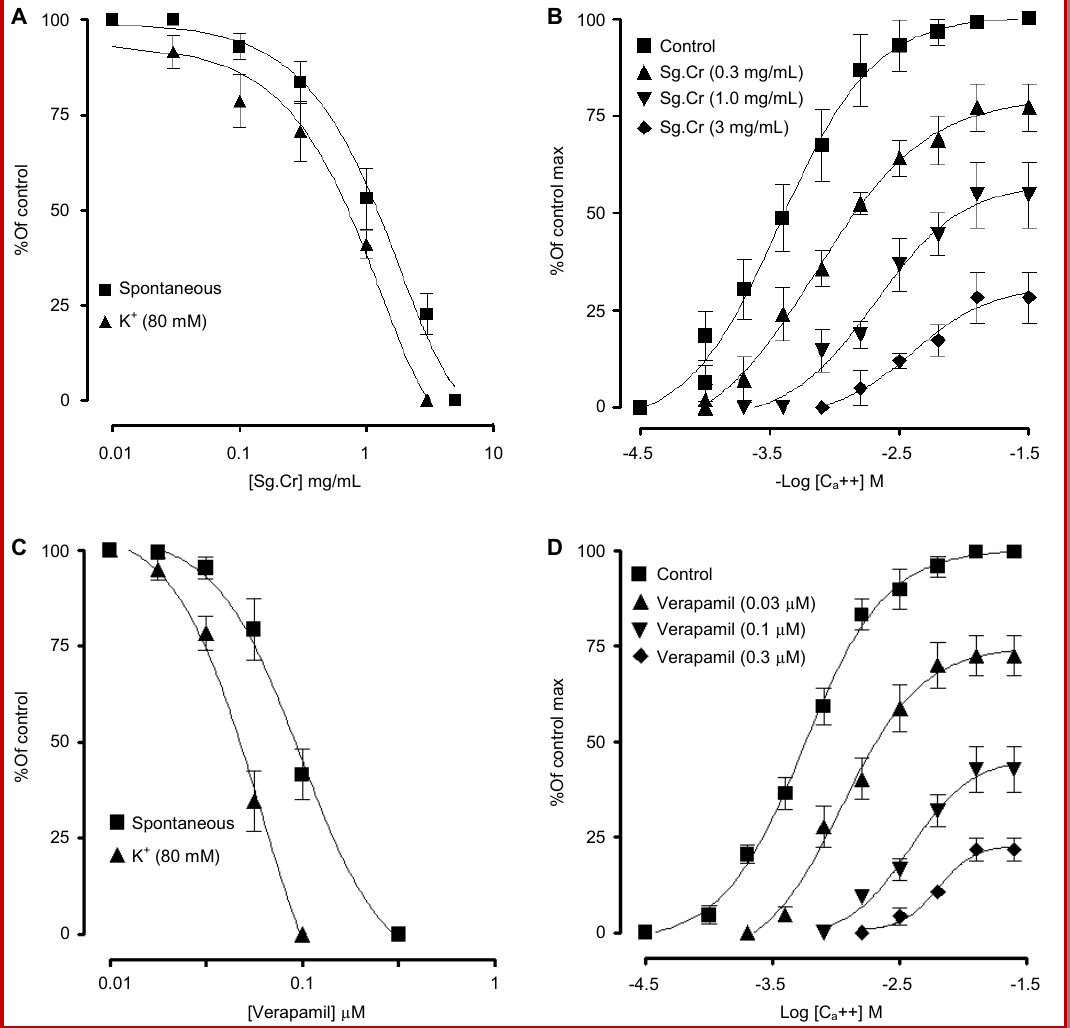
Figure 2: The concentration response curves (CRCs) of the crude extract of S. guttatum (A) and verapamil (C) on spontaneous and high K+ (80 mM)-induced contractions in isolated rabbit jejunum preparations. The CRCs on the right panel represents calcium curves in the absence and presence of the crude extract (B) and verapamil (D) showing dose-dependent rightward shift and sup- pression of maximum response in the calcium